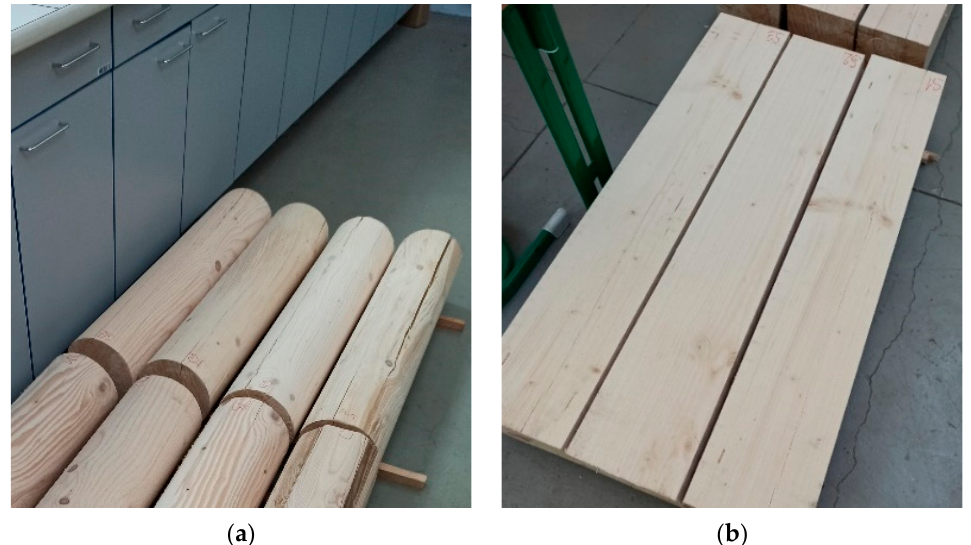
Figure 2. Samples for medium-scale fire tests: ( a ) circular cross-section (logs); ( b ) square cross-section (prisms).